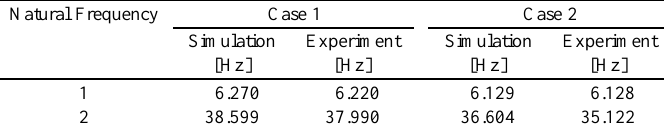
Table 4 Natural frequencies of the smart beams considered in Case 1 and Case